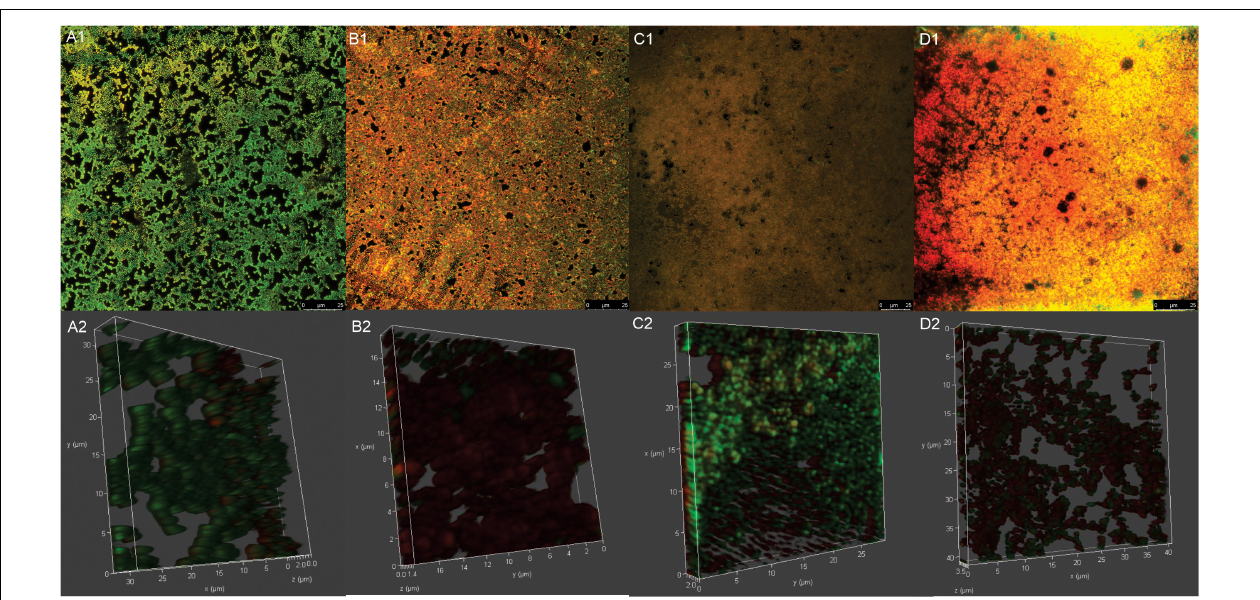
FIGURE 5 | Confocal laser scanning microscopy images of mature biofilm of Streptococcus agalactiae ATCC 13813 untreated control (A1,A2) and treated with copaiba oil (B1,B2) , CARB-BF (C1,C2) and CARB-CO 1.0 (D1,D2) . Biofilms were formed on CELLview TM cell culture dish with glass bottom during 24 h at 37 ◦ C before the treatments. Cells were stained with SYTO 9 R (cid:13) (green-fluorescent) and propidium iodide (red-fluorescent). Panoramic view of biofilm (A1–D1) . Three-dimensional biofilm reconstitution (A2–D2) .